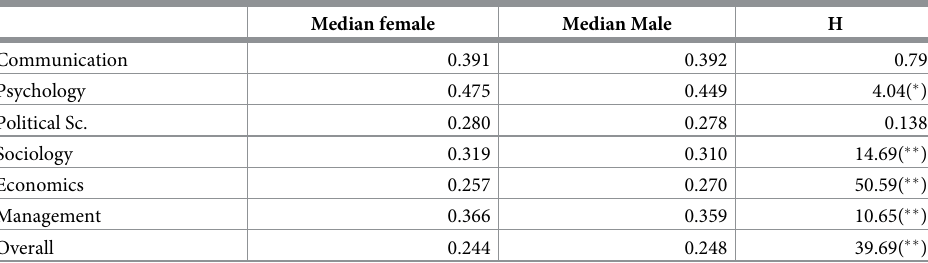
Table 5. Differences in gender for closeness centrality for each field and for the overall